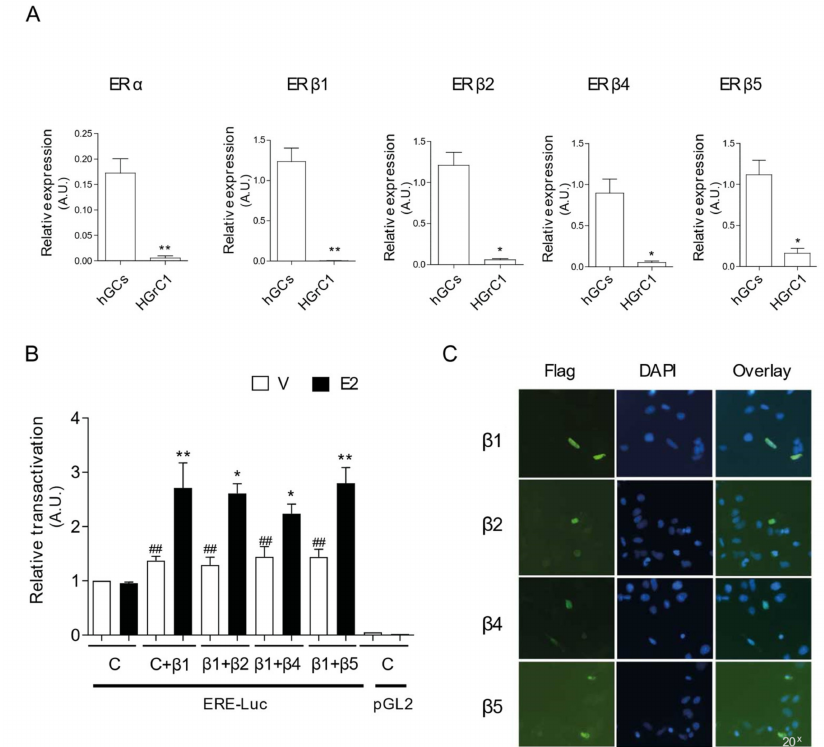
Figure 4. Absence of influence of ER β 2/ β 4/ β 5 on E2-induced ER β 1 transactivation in HGrC1- transfected cells. ( A ) The presence of ER α and ER β (1, 2, 4, and 5) isoforms mRNA in hGCs ( n = 49) and HGrC1 cells ( n = 6) was evaluated by RT-qPCR (expression normalized to GAPDH). Values are represented as means ± SEM from three identical wells per patient, measured in triplicate. * p ≤ 0.05; ** p ≤ 0.01 by the Mann–Whitney test. A.U., Arbitrary Units. HGrC1 cells express low levels of endogenous ER α and ER β isoforms, when compared to those expressed in hGCs. ( B ) HGrC1 cells were transiently cotransfected with the control Flag vector (C) alone or with the Flag-ER β 1 vector ( β 1), together with the Firefly luciferase reporter plasmid containing or not (pGL2) estrogen-response elements (EREs) upstream of luciferase (ERE-Luc). Flag-ER β 1 was also cotransfected (1:1 ratio) with either Flag-ER β 2 ( β 1+ β 2), Flag-ER β 4 ( β 1+ β 4), or Flag-ER β 5 ( β 1+ β 5). Renilla luciferase reporter plasmid was included as a normalizing transfection control. Twenty-four hours after solvent vehicle (V) or 10 nM E2 treatment, cells were lysed and analyzed for luciferase activity. Firefly luciferase activity was normalized to that of Renilla luciferase and reported as relative transactivation activities arbitrarily set at 1 for the control (C) solvent vehicle (V) condition in ERE-Luc-transfected cells. Each point represents the mean ± SEM in six replicates performed four times. * p ≤ 0.05; ** p ≤ 0.001 vs. vehicle (V) for each group of cotransfection, and ## p ≤ 0.001 vs. control (C) vehicle (V) using the Mann–Whitney test. A.U., Arbitrary Units. ( C ) HGrC1 cells were transiently transfected with either Flag-ER β 1 ( β 1), Flag-ER β 2 ( β 2), Flag-ER β 4 ( β 4), or Flag-ER β 5 ( β 5). Twenty-four hours post- transfection, cells were fixed, permeabilized, and the localization of Flag-ER β proteins was monitored by immunofluorescence using an anti-Flag antibody (green). Nuclei were stained with DAPI (blue). Representative images at 20 × magnification are